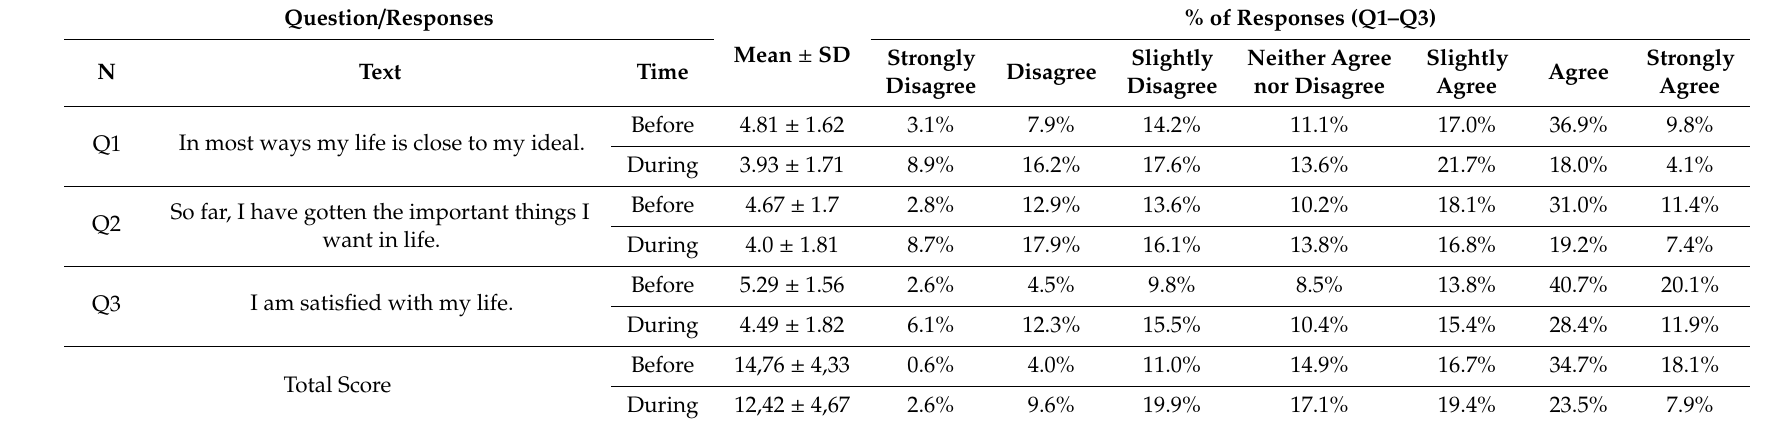
Table 5. Distribution of responses (%) in each item of the life satisfaction